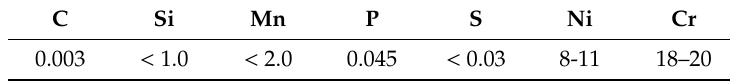
Table 1. Chemical composition of SS-304 (mass fraction, %). C